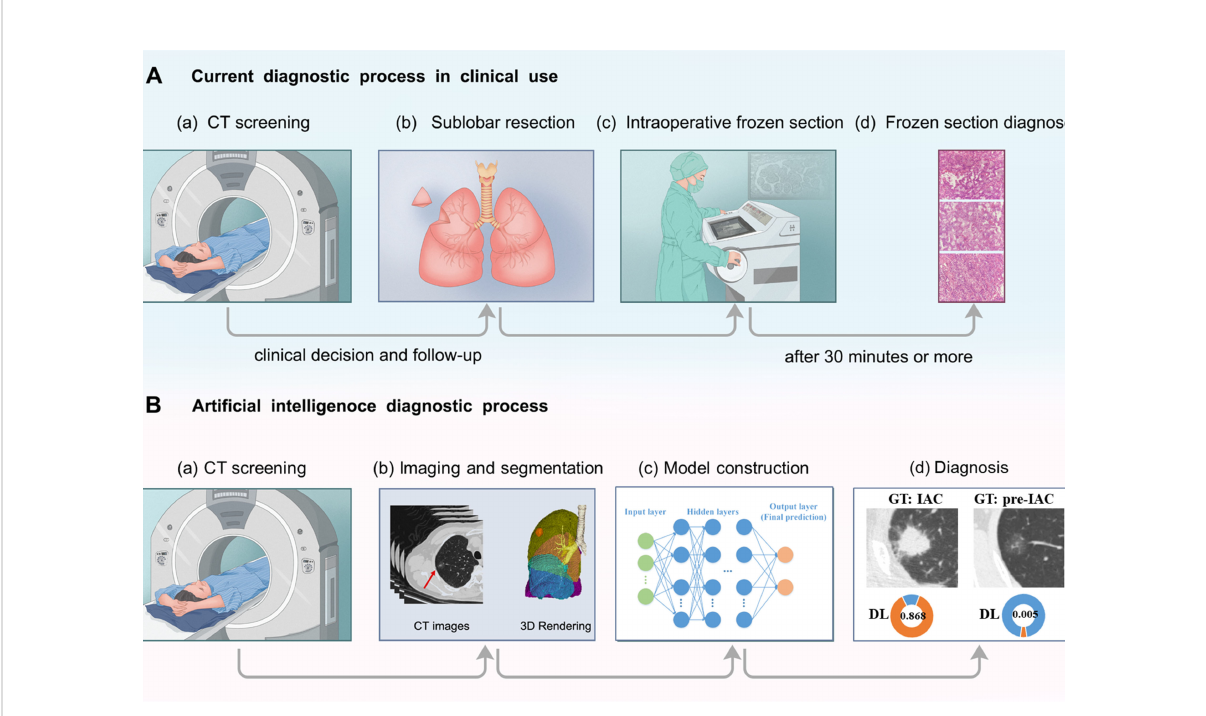
FIGURE 2 Diagram of (A) current and (B) arti fi cial intelligence procedures to determine histological invasiveness. In the current diagnostic process in clinical use, sublobar resection is performed and intraoperative frozen sections decide the extent of surgery. In the other hand, in the work fl ow of deep learning approach, extensive information could be extracted from CT images, and help with the determination of tumor invasiveness. “ GT ” refers to ground truth. “ DL ” represents deep